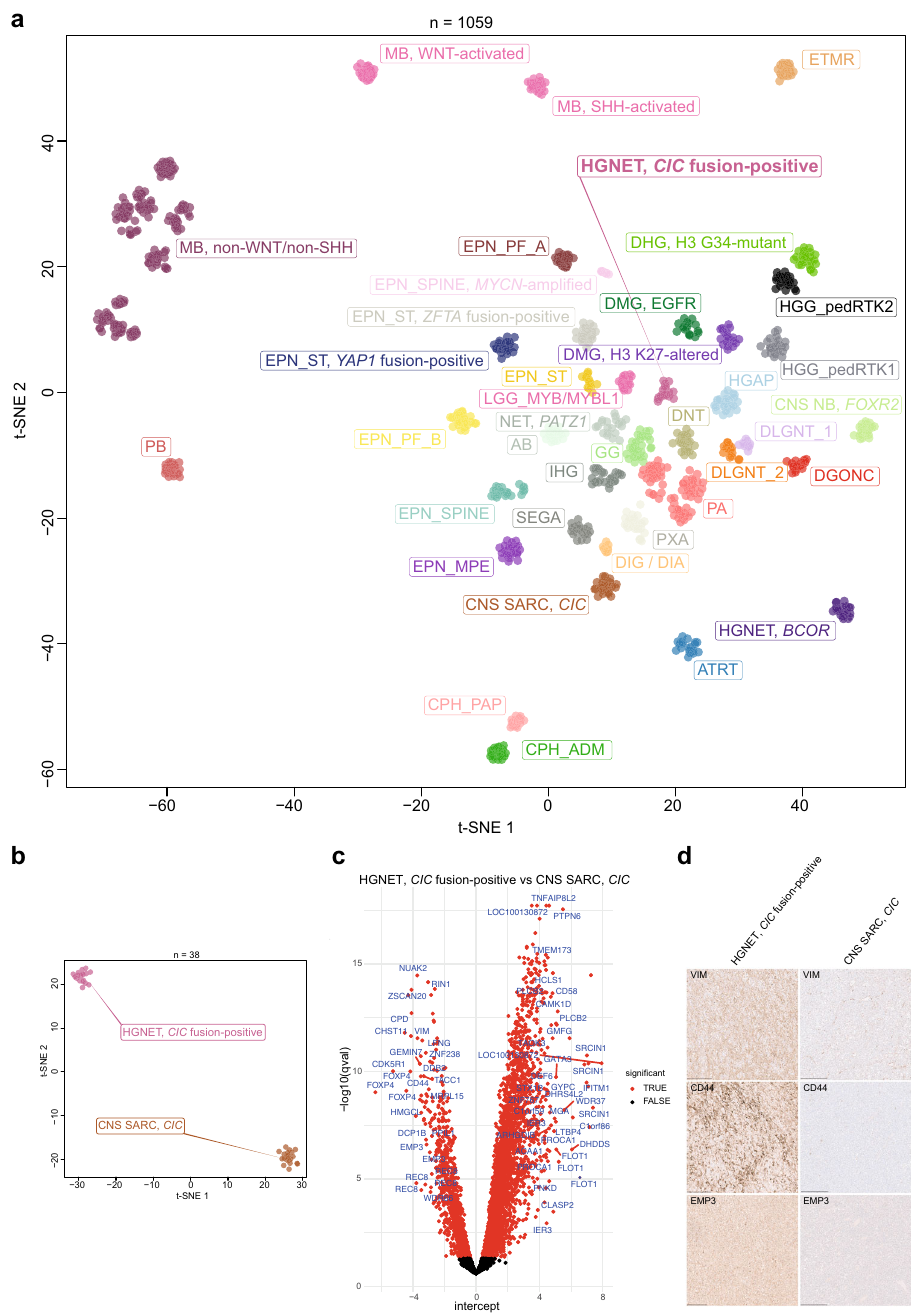
Fig. 1 Molecular classi fi cation of high-grade neuroepithelial tumors CIC fusion-positive by DNA methylation pro fi ling. a Unsupervised, nonlinear t-distributed stochastic neighbor embedding (t-SNE) projection of DNA methylation array pro fi les from 1059 tumors. DNA methylation pro fi ling reveals a molecular distinct group of high-grade neuroepithelial tumors (HGNET, CIC fusion-positive; n = 18). b t-SNE analysis of DNA methylation array pro fi les of HGNET, CIC fusion-positive, and CIC -rearranged sarcoma (CNS SARC, CIC ). For DNA methylation class abbreviations, see Supplementary Table 2. c Volcano plot comparing differentially methylated probes between HGNET, CIC fusion- positive and CNS SARC, CIC . d Immunohistochemical expression of vimentin (VIM), CD44, and EMP3 in HGNET, CIC fusion-positive and CNS SARC, CIC . Scale bars 300 μ